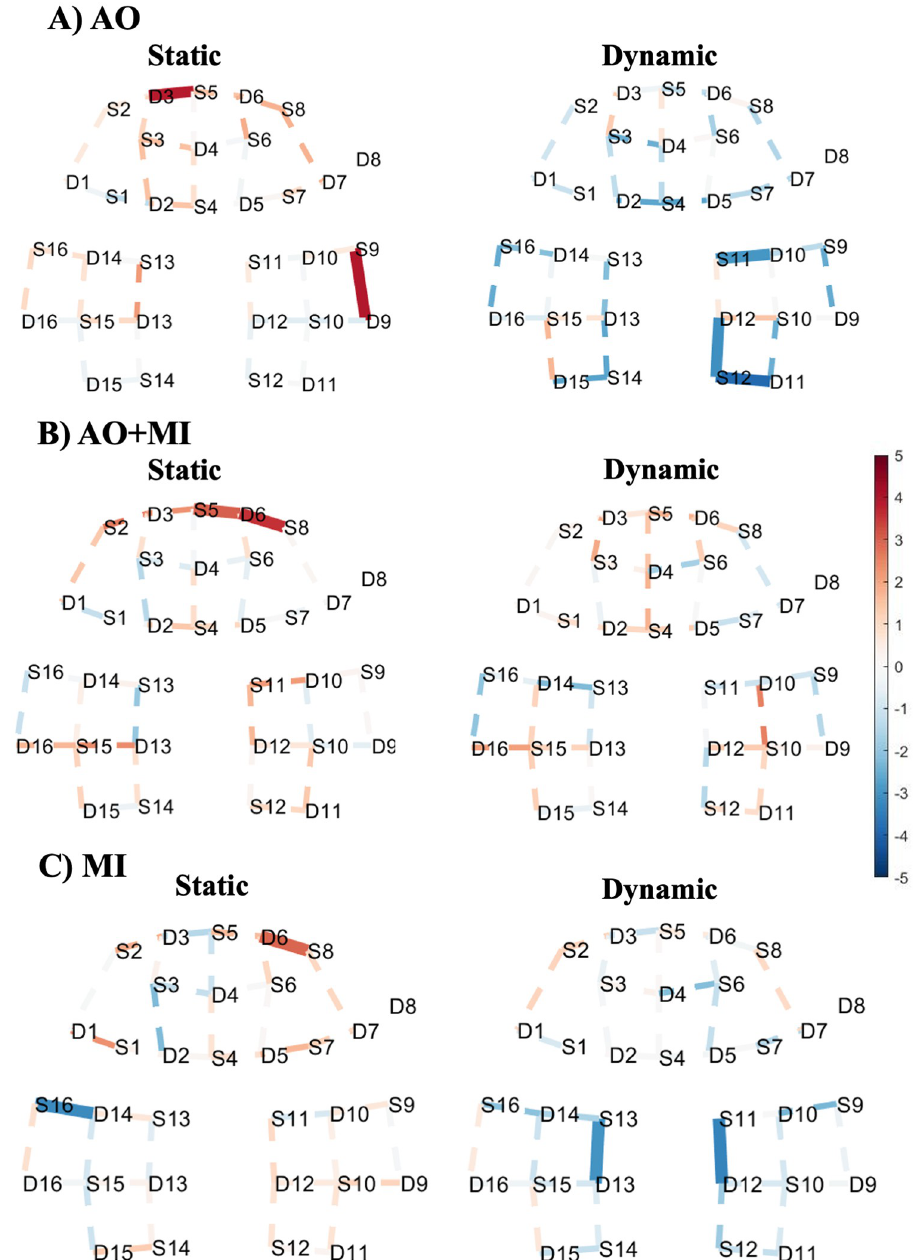
Fig 4. T-map of deoxy-hemodynamic response (HbR) corresponding to (A) action observation experiment, (B) a combination of motor imagery and action observation experiment, and (C) motor imagery experiment during static standing balance task (left) and dynamic standing balance task (right). These maps are generated by contrasting each task against the baseline. Significantly activated channels at p < 0.05 (FDR corrected) are indicated by thick and solid lines. The red colour indicates stronger task activity against the baseline. The dashed line shows the channels that were not statistically significant. This map was generated by using NIRS Brain AnalyzIR Toolbox [51]. Fig 2 illustrates the referencing for the brain regions with 10–20 EEG system